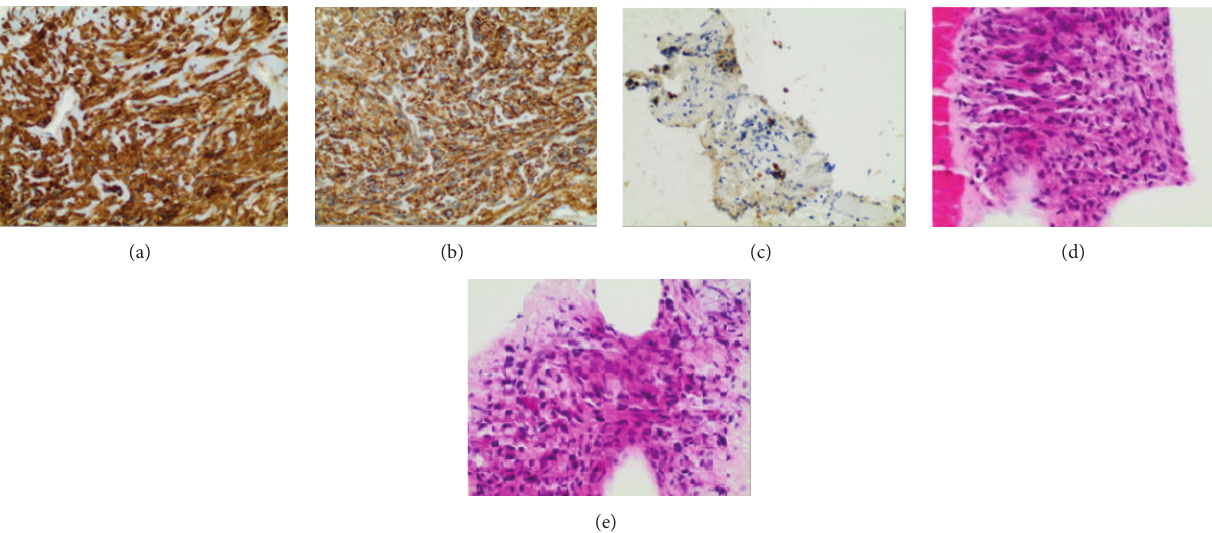
Figure 3: Pathology shows spindle cell lesion composed of intersecting fascicles and relatively bland spindle cells. (a) CD117, (b) DOG1, (c) spindled tumor cells which are negative for pancytokeratin, (d) atypical spindle cells on H&E stain, and (e) atypical spindle cells on H&E